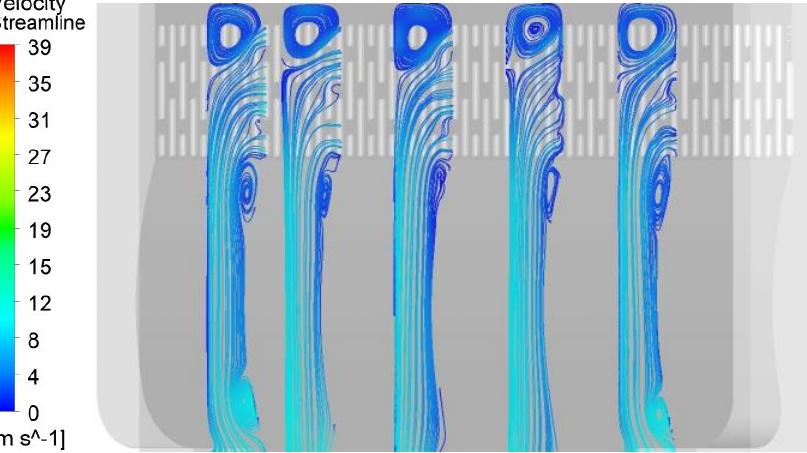
Figure 11. Flow diagram of the X-directional cross-section within the initial optimized head duct of the integrated stove.